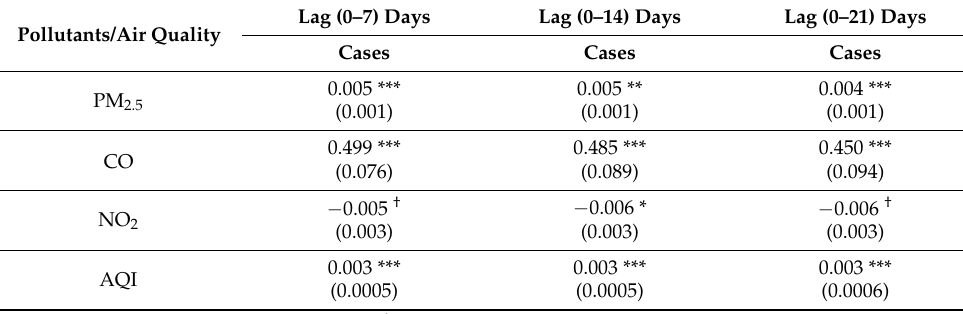
Table A3. GAMs using a moving average of lag 9 on all the meteorological factors.